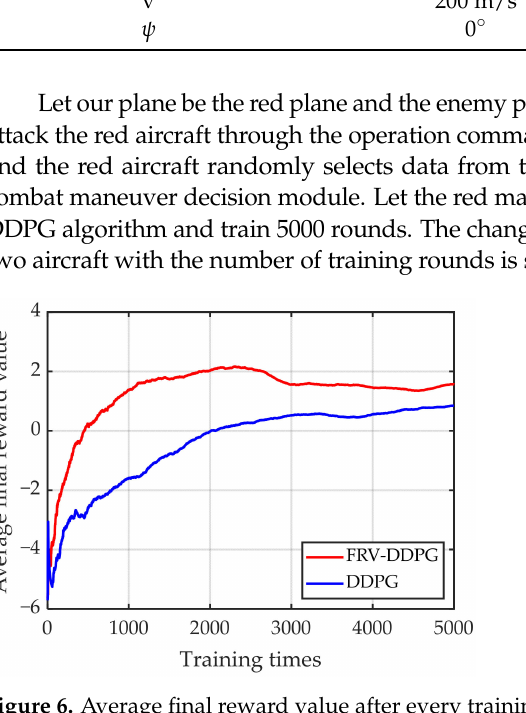
Figure 6. Average final reward value after every training